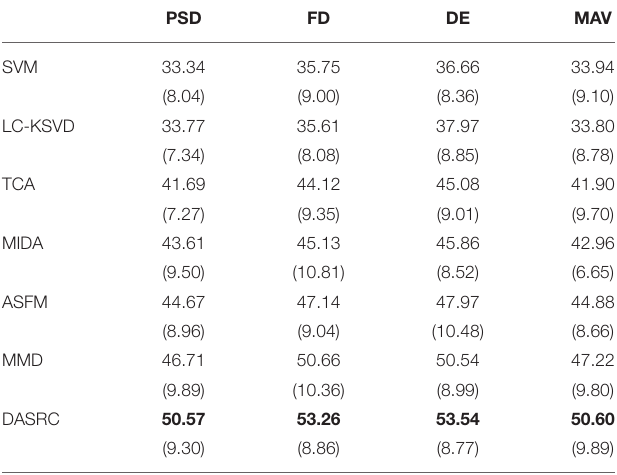
TABLE 2 | Cross-dataset accuracy % (std %) of DASRC using different features on SEED → DEAP. PSD FD DE